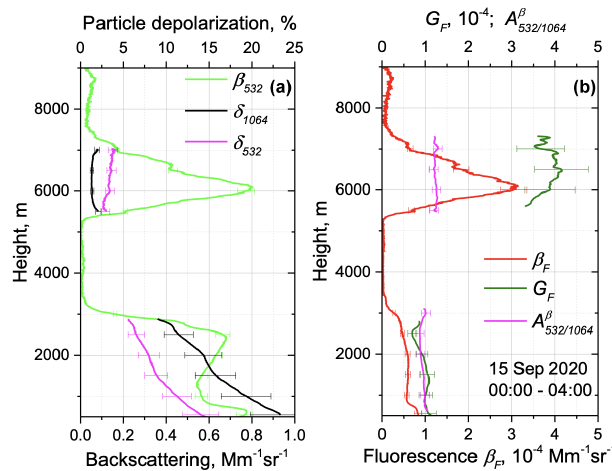
Figure 10. Vertical profiles of (a) backscattering coefficient β 532 and particle depolarization ratios δ 532 and δ 1064 . (b) Fluorescence backscattering β F , fluorescence capacity G F , and backscattering Ångström exponent A β on 15 September 2020 for the pe- 532 / 1064 riod